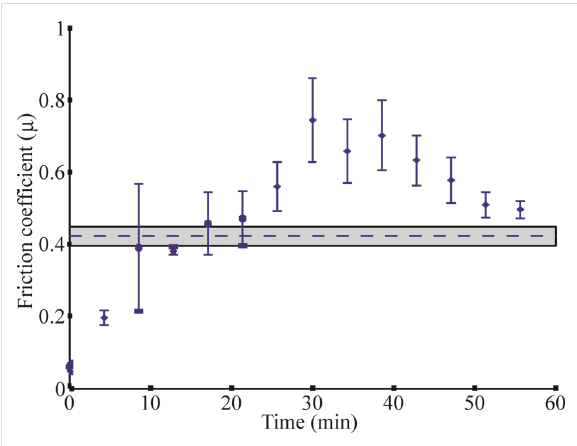
Figure 5: Dynamics of the friction coefficient, µ. The friction coefficient was calculated according to Equation 2 with λ = 7.75 and c = 0.012. The mean value of the friction coefficient for dry seeds is shown by the dotted line inside the gray box (standard deviation). Mean values of the friction coefficient for hydrated seeds are shown by stars, and error bars indicate standard